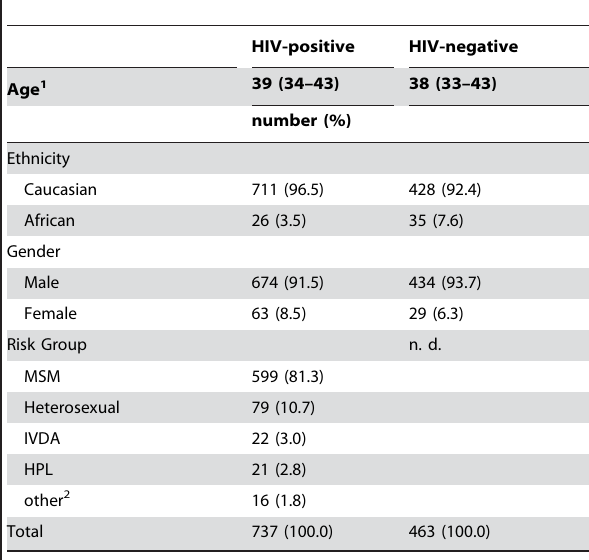
Table 2. Demographic characteristics of HIV positive and